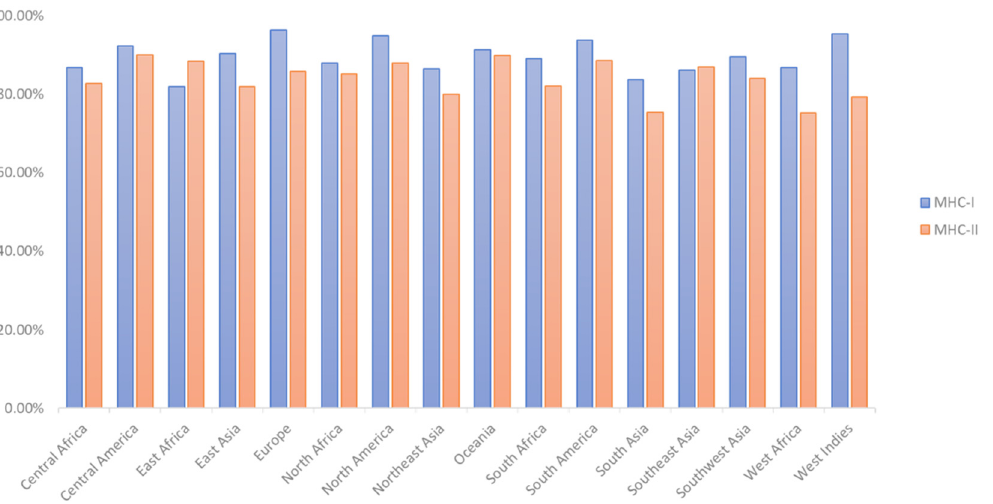
Figure 2. Antigenicity based on MHC-I and MHC-II population coverage study of anticipated T-cell epitopes.